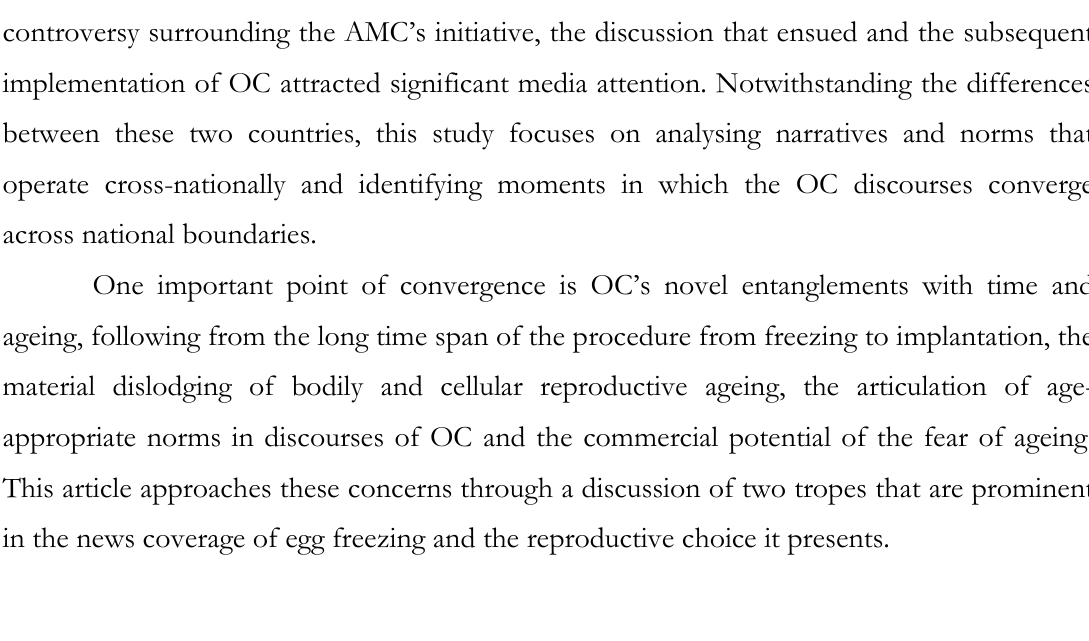
Lucy van de Wiel, For Whom The Clock Ticks: Reproductive Ageing and Egg Freezing in Dutch and British News Media Studies in the Maternal , 6(1), 2014,